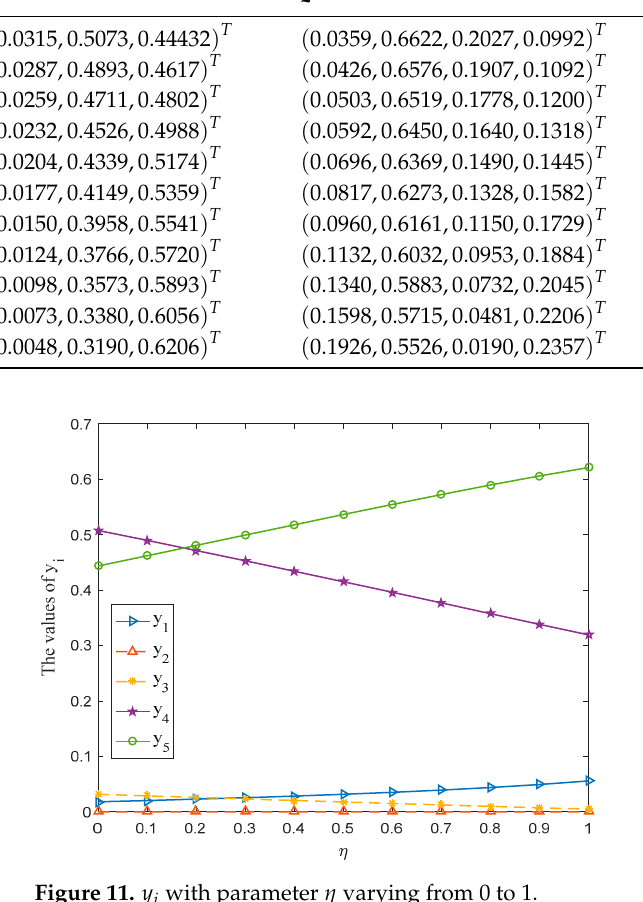
Figure 12. j z with parameter η varying from 0 to 1. Figure 13. The gain-floor U ∗ and